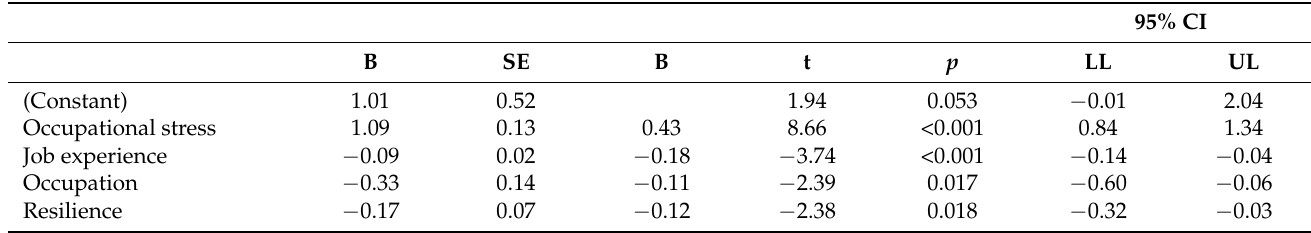
Table 5. Multiple linear regression model explaining intention to